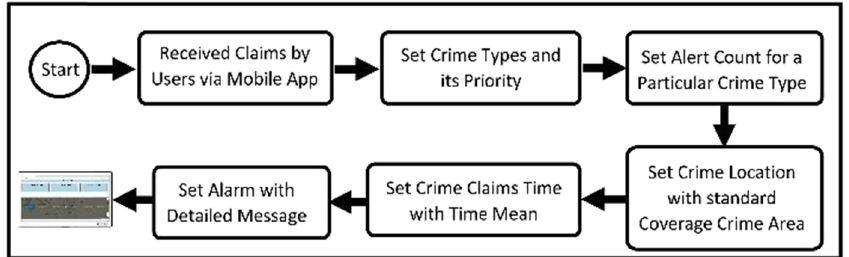
Figure 4: Presents the steps for controlling and validating the report system.